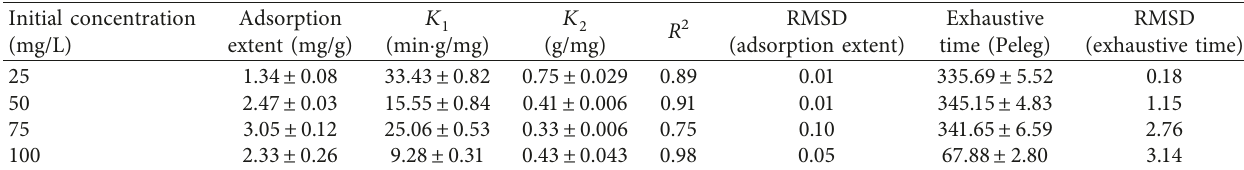
Table 3: Values of adsorption extent, Peleg’s constants ( K mean squared deviation (RMSD) at different initial concentrations.